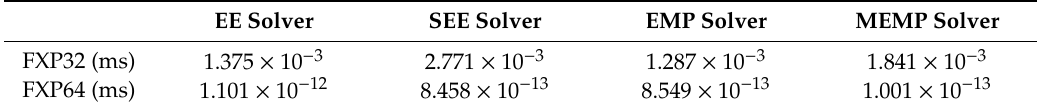
Figure 7. The refractory periods of the EE, SEE, EMP, and MEMP solvers of the system (1) while sending two pulse signals with amplitude A = 20 µ A. The subgraph shows the observable di ff erence between solutions obtained by various methods. Table 2. The maximum values of discrepancy in the time of occurrence of the second spike for DBL and FXP solvers while sending two pulse signals with amplitude A = 20 µ